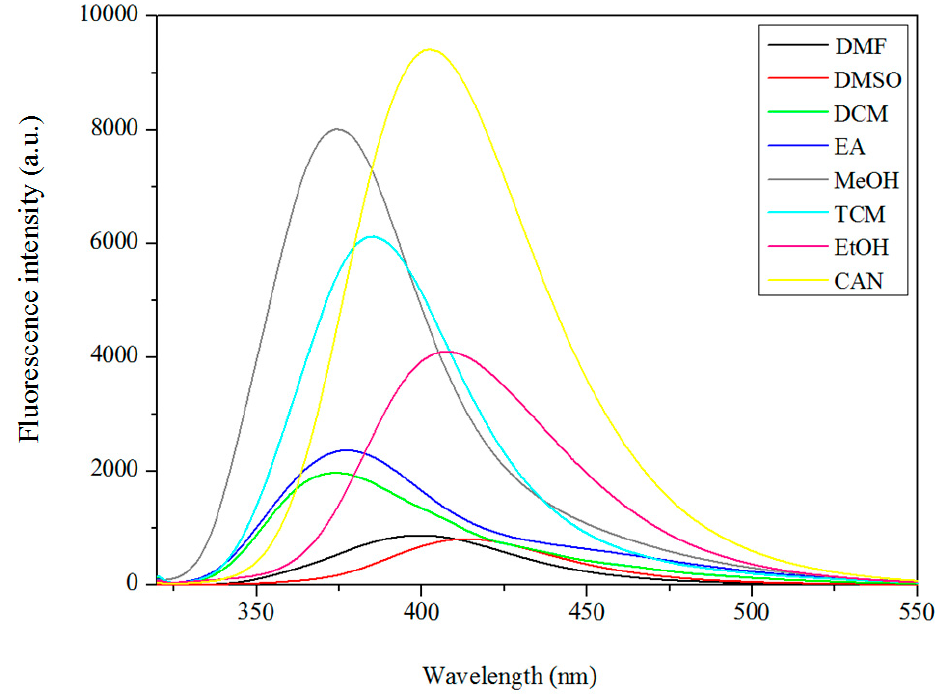
Figure 11. The fluorescent ( λ ex = 315 nm) spectra of complex 2 (2.5 × 10 − 5 M) in various solvents.